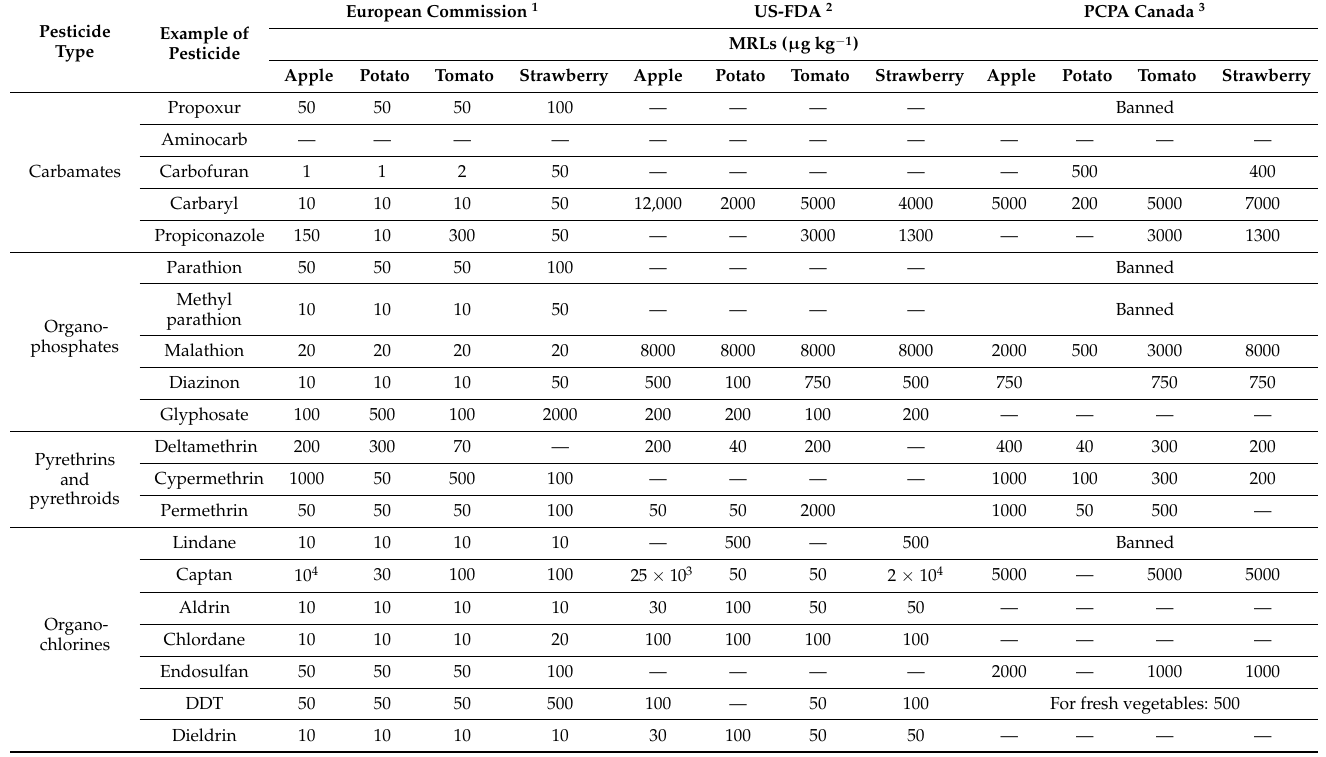
Table 2. The MRLs for fruits and vegetables in the United States, Canada, and